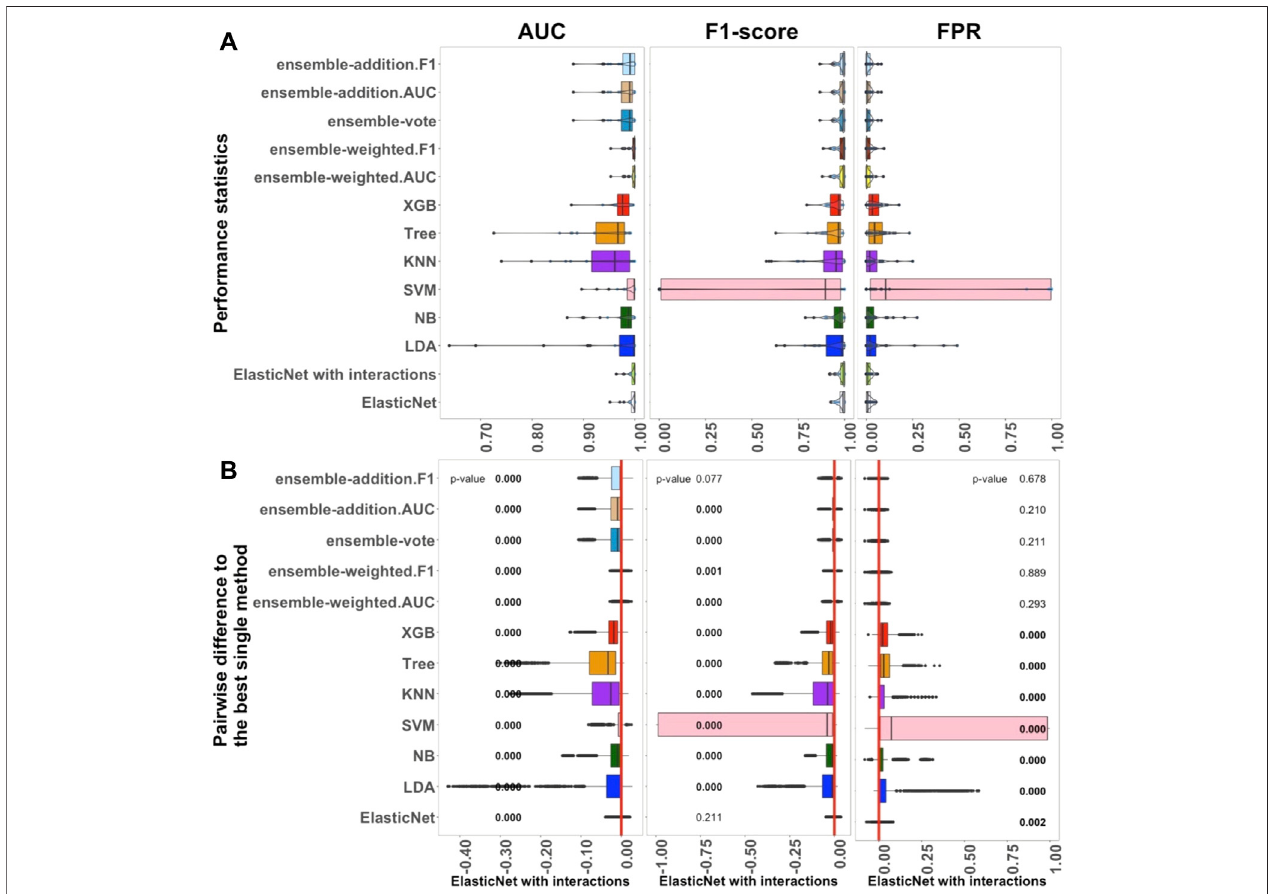
FIGURE1| Performanceof13algorithmswiththe27smalldatasets. Thevaluesofthreecriteria(AUC,F1-score,andFPRfromlefttoright)areshownin (A) .There are 2,700 points in each box. The values of three criteria are used to represent the performance of the corresponding algorithm. (B) Differences between the best single algorithmandtheotheralgorithms.Fromlefttoright,theresultsshowthedifferencesinAUC,F1,andFPRincludingthe p -valuesfromtheWilcoxontest; p -values < 0 . 05 are indicated in bold, and the red lines indicate the zero value. The best single method is shown at the bottom of each box.